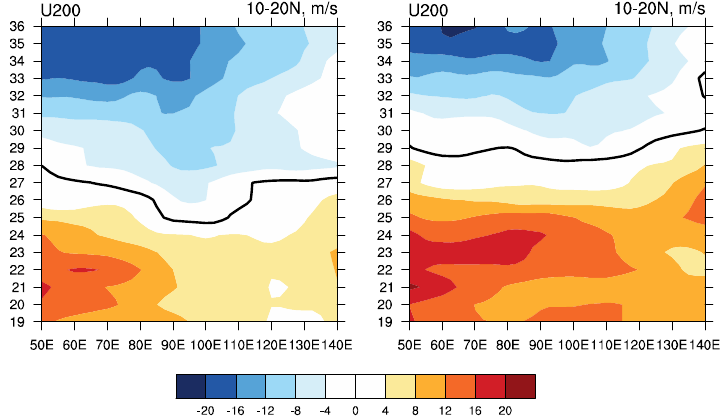
Figure 10. Hovmöller diagram of composite zonal wind at 200 hPa (shading; m/s) along 10°–20° N from Pentad 19 to Pentad 36 in the North (left) and South (right) track cases. Thick contour indicates zero.